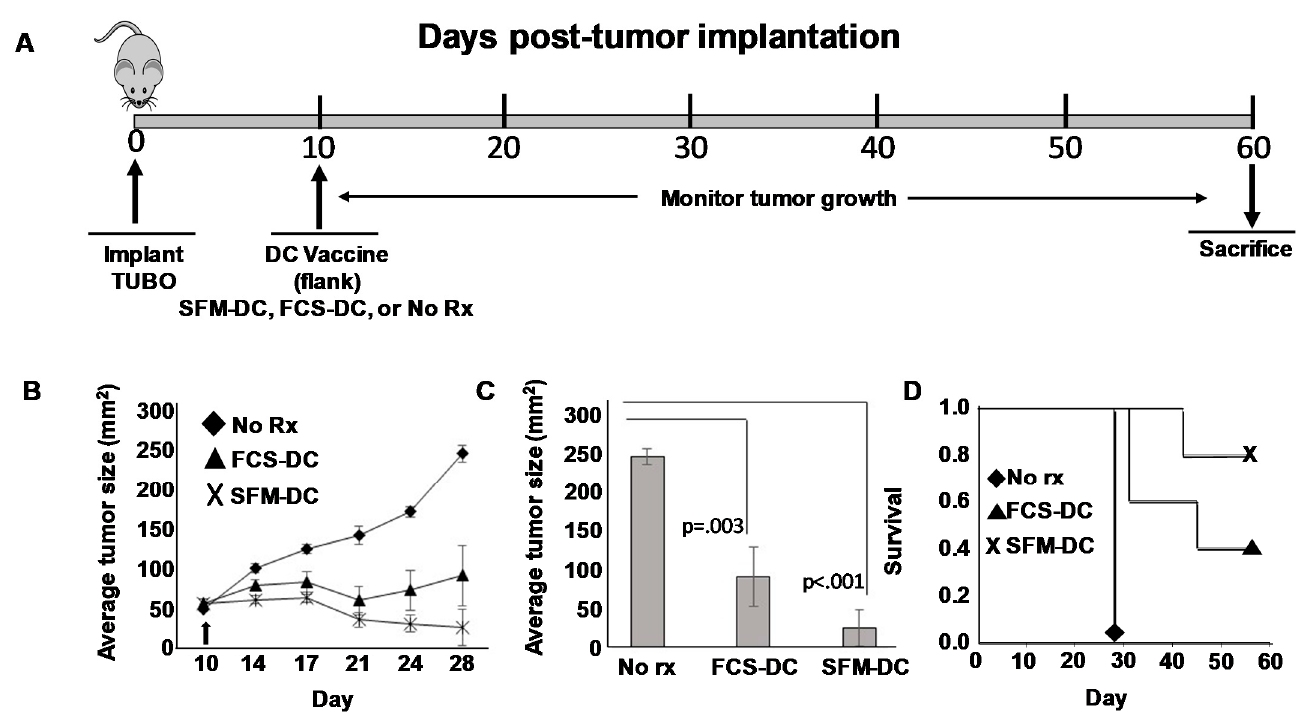
Figure 3. Comparison of efficacy of peptide ‐ pulsed DCs cultured in serum ‐ free versus serum ‐ replete medium in a therapy model for HER2 pos breast cancer. ( A ) Schema of therapy protocol. On day 0, fifteen female Balb/c mice received 1 × 10 6 orthotopically ‐ implanted TUBO breast carcinoma cells. On day 10 mice were divided into three groups (five mice each) and vaccinated subcutaneously in the flank with rat ErbB2/HER2 class I peptide (TYVPANASL) pulsed either onto DCs cultured in X ‐ Vivo 20 (SFM ‐ DC) or in RPMI supplemented with 10% fetal calf serum (FCS ‐ DC). Alternatively, mice were left untreated (No Rx). ( B ) growth curves of tumors over the course of 28 days. ( C ) Average tumor size comparison on day 28 with statistical analysis. ( D ) Kaplan–Meyer survival plot where vaccinated mice were followed for an additional 30 days. Failure to survive was defined as tumor size exceeding size of 200 mm 2